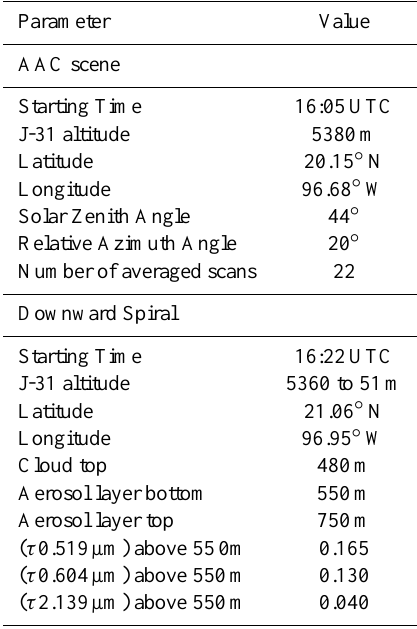
Table 2. Geometry and other parameters associated with our AAC scene, and the subsequent downward spiral. Aerosol optical depths are from the AATS